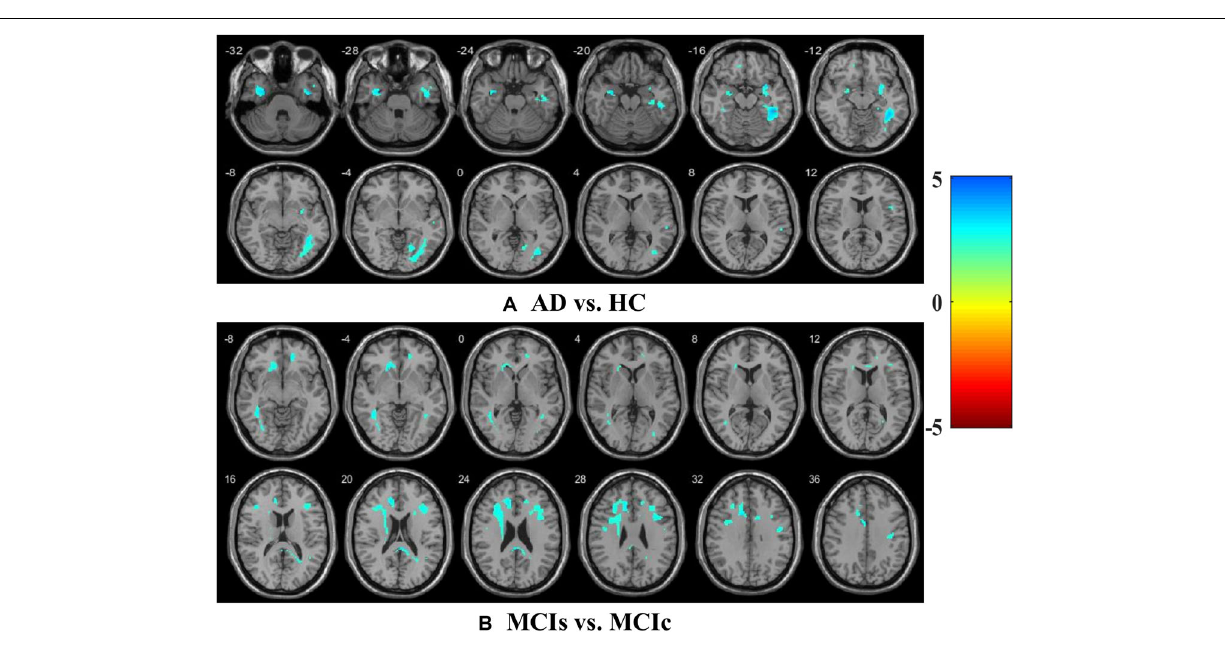
FIGURE 7 | Affected region for (A) AD vs. HC, and (B) MCIs vs. MCIc is shown using AV45-PET